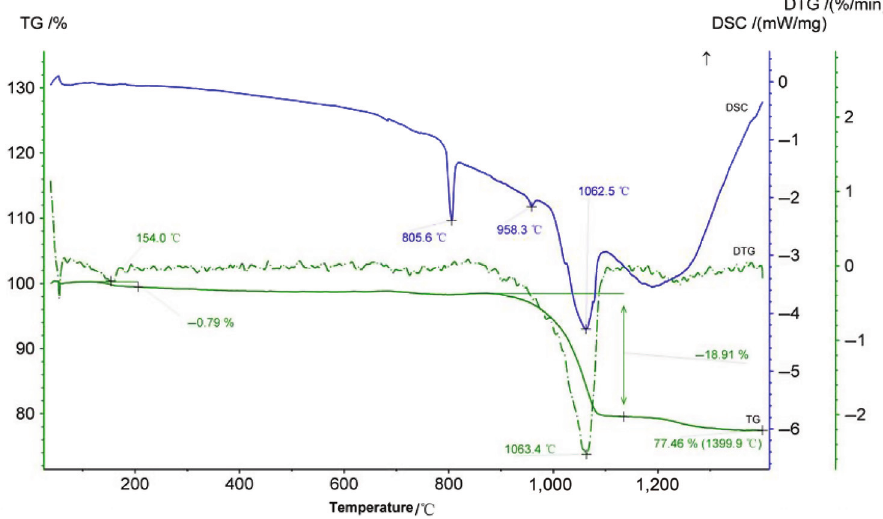
Figure 10: TG-DSC analysis of BaCO 3 powders prepared under the optimal experimental